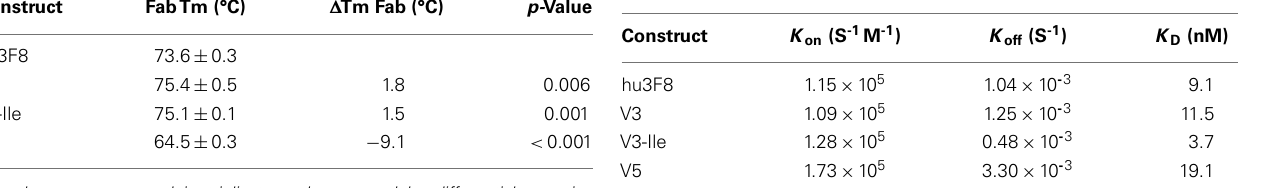
Table 5 |Analysis of binding kinetics measured by surface plasmon resonance .